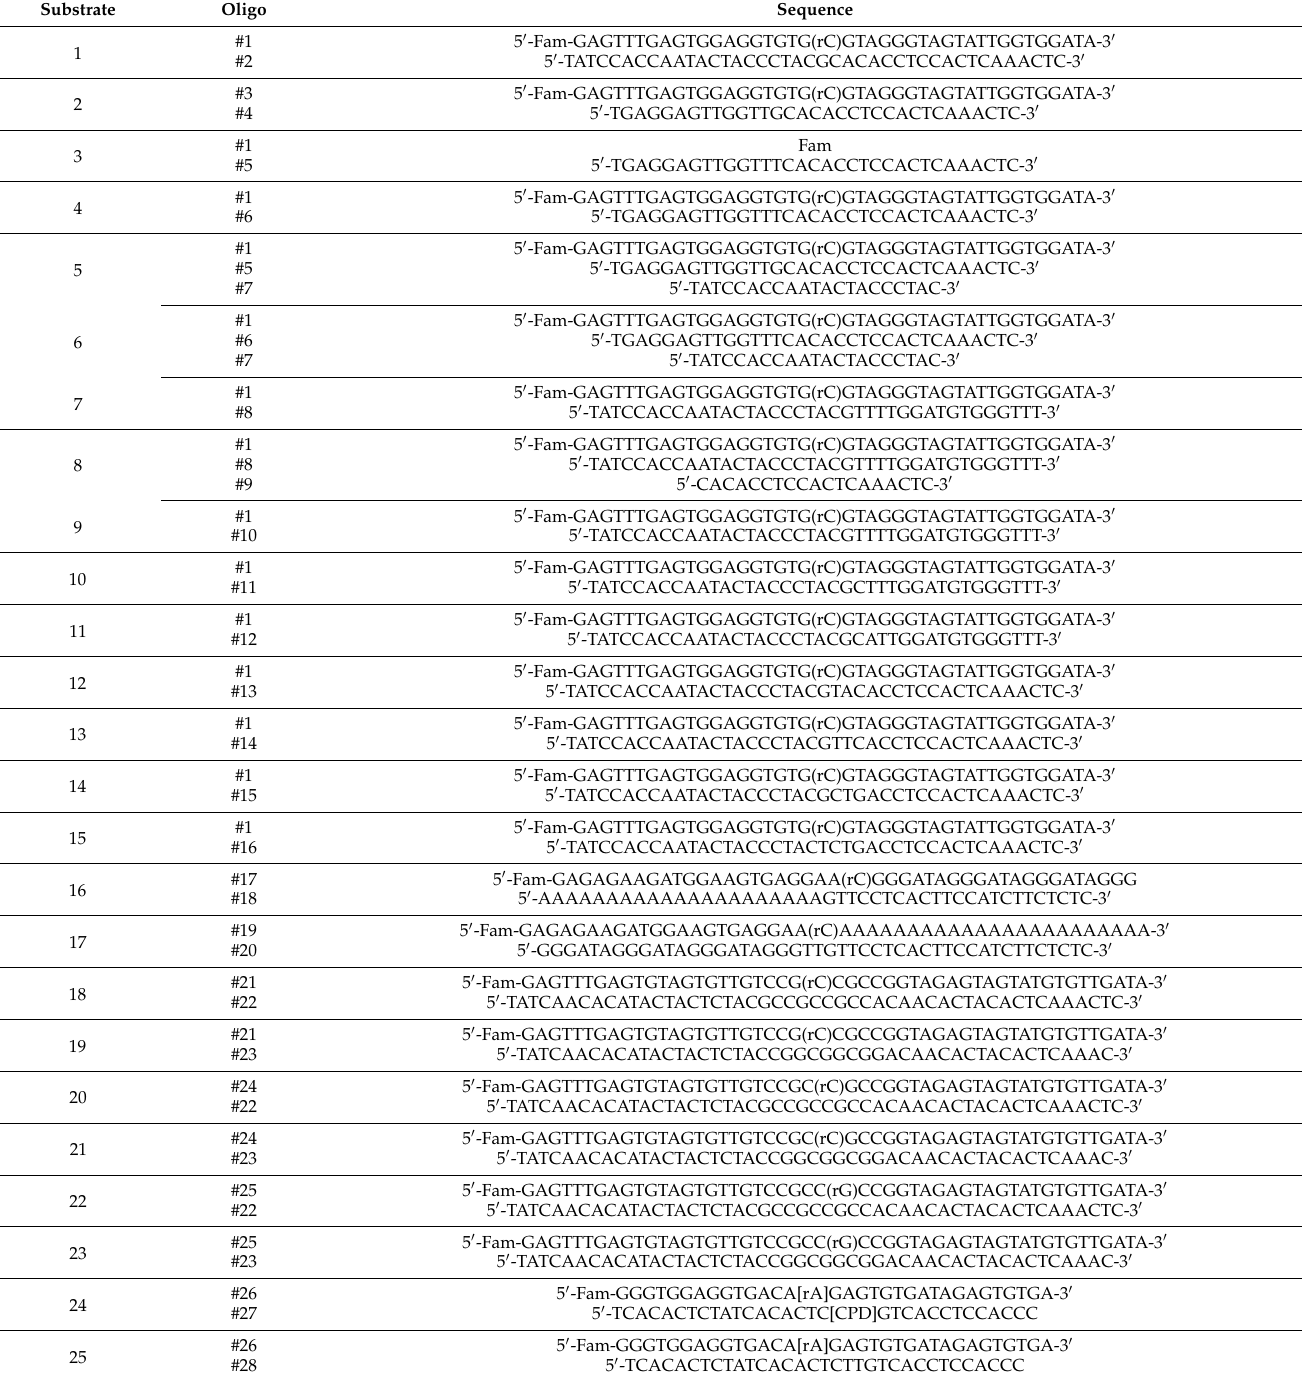
in Table 1. Where indicated, oligonucleotides were directly synthesized as 5 (cid:48) -labelled with carboxyfluorescein (Fam) group. Each substrate was obtained by mixing the proper oligonucleotides at a 1:1 (M/M) ratio in annealing buffer (30 mM HEPES KOH pH 7.4, 100 cooled down to room temperature. To avoid the generation of a G-quadruplex structure (Substrates 16 and 17 ), oligonucleotides #17–#18 and #19–20# were mixed into a modified annealing buffer in which 100 mM KCl was substituted with 100 mM LiCl and HEPES KOH with HEPES LiCl. If unspecified, all reagents come from AppliChem (Darmastadt, Germany). Table 1. Substrates and oligonucleotides